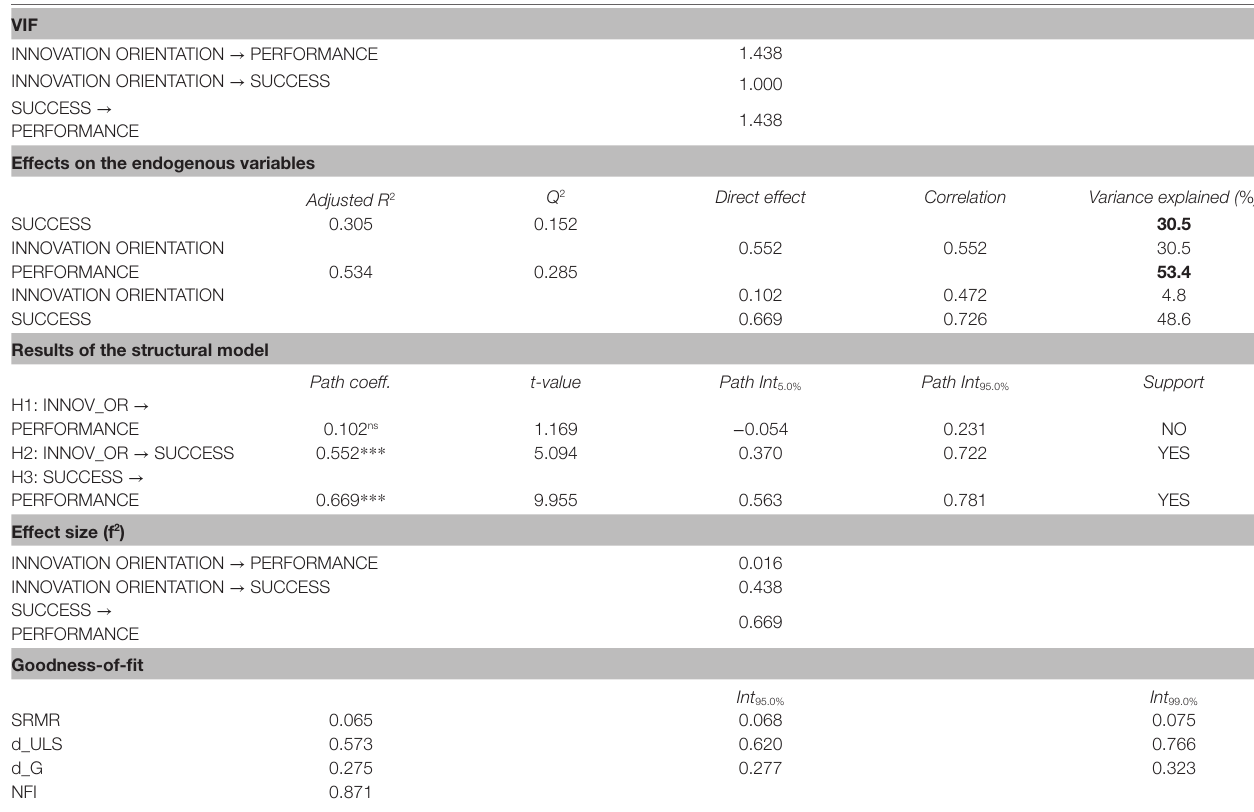
TABLE 9 | Indicators of the structural model analysis.